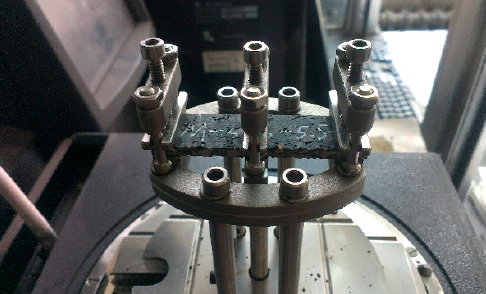
Figure 5. Sample with dual cantilever clamp.